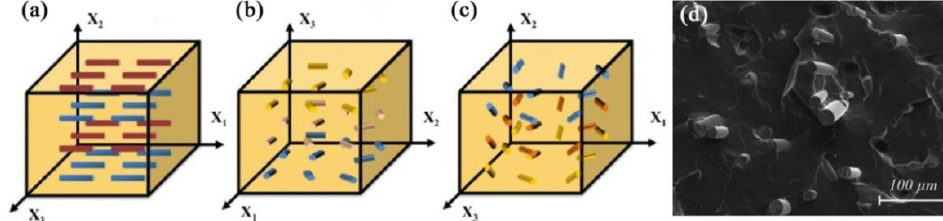
Figure 5. Models based on the periodic distribution of inclusions and SEM of PU-MG fractured surfaces: ( a ) Uniaxially oriented distribution, where fiber axis is always parallel to X 1 axis; ( b ) In-plane oriented distribution, where fiber axis always lies on X 1 X 2 -plane; ( c ) three-deminsional randomly oriented distribution; ( d ) SEM. Reproduced with permission from refs. [71,72].